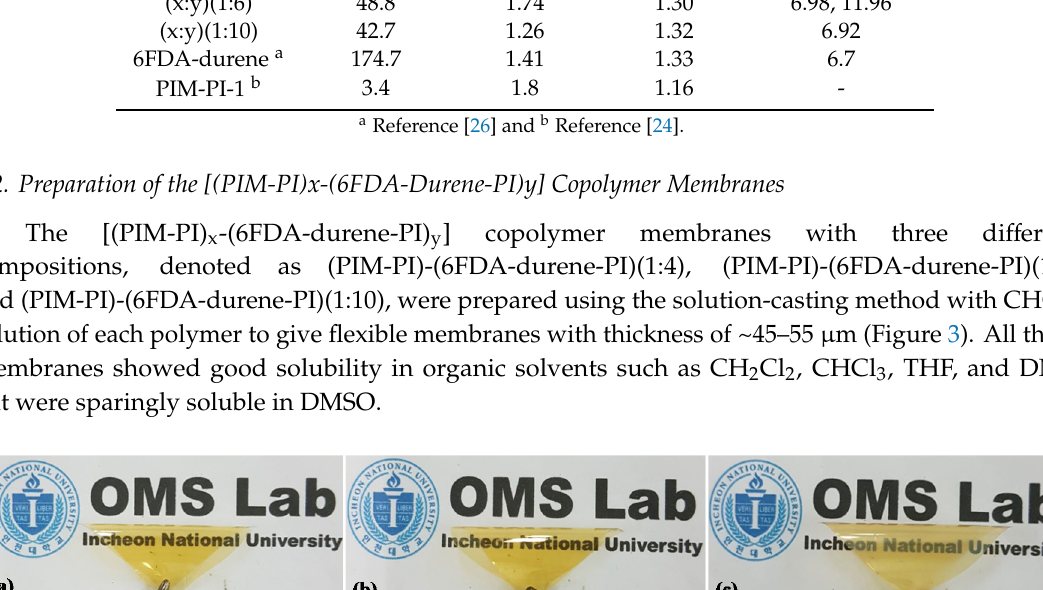
Figure 3. Pictures of the [(PIM-PI)x-(6FDA-durene-PI)y] copolymer membranes with 1:4 ( a ), 1:6 ( b